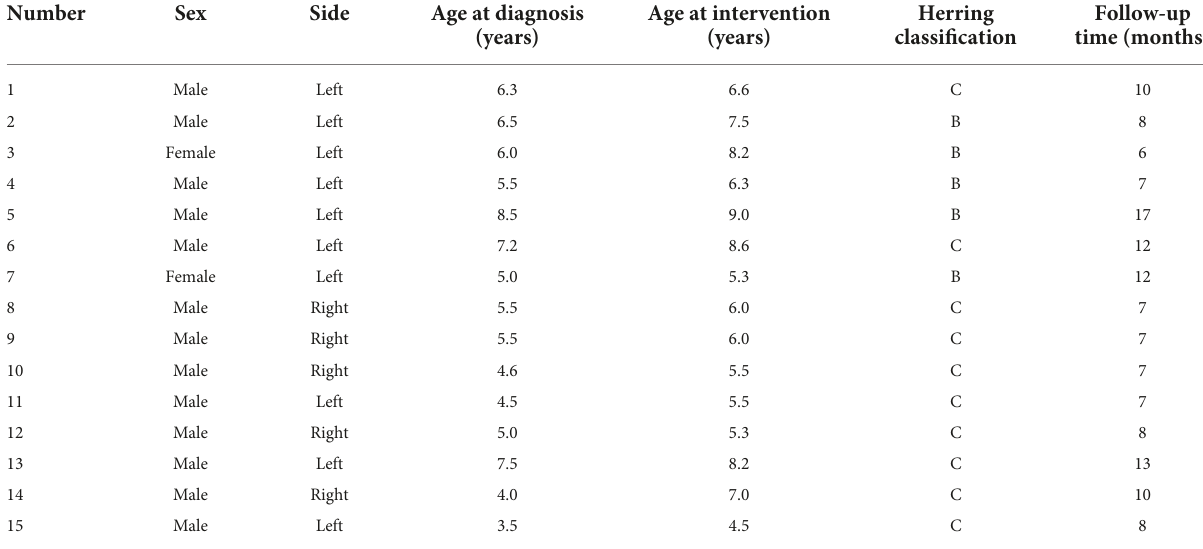
TABLE 1 The demographic data of the Legg-Calvé-Perthes disease (LCPD) patients. Number